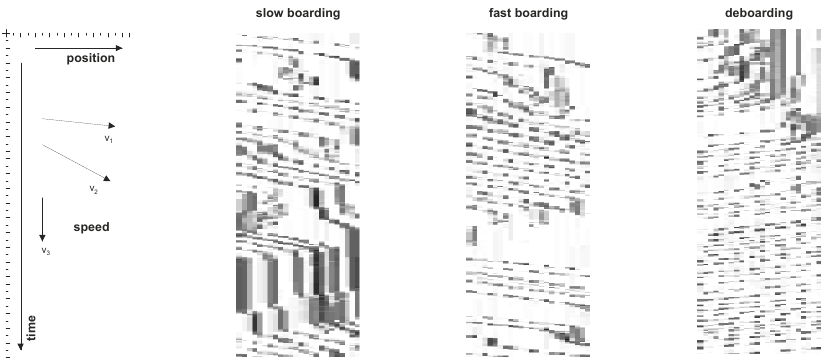
Figure 20. Feedback from the floor sensors indicating walking speeds and passenger queues in the aircraft cabin.